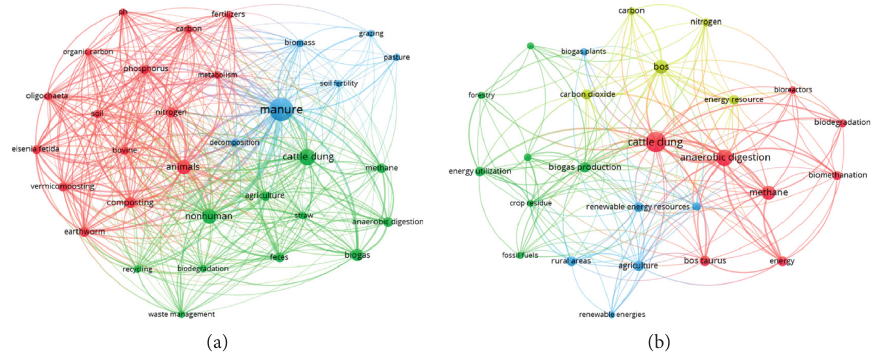
Figure 2: Scientometric analysis of utilization of cattle dung as (a) manure and (b) energy source.